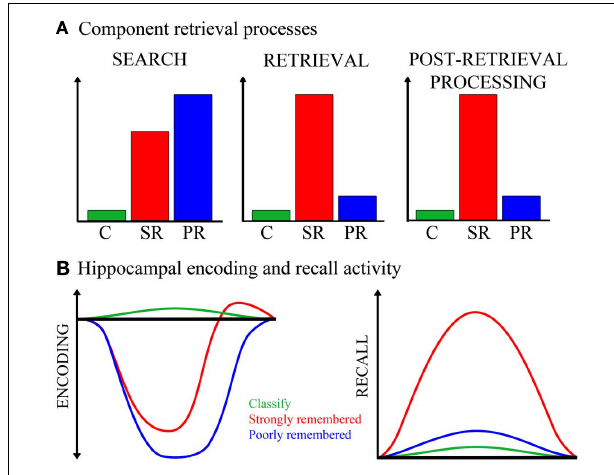
FIGURE 5 | Cognitive and neural processing models. (A) The hypothetical cognitive processes involved in an elaborative associative retrieval task, and the magnitude to which each task condition engages these processes, are depicted.The y -axis represents arbitrary units measuring degree of engagement. From this model, the following cognitive processes are expected to result from task condition contrasts: If engaged more for strongly remembered than classify, the process(es) might be search, retrieval, or post-retrieval processing; if engaged more for poorly remembered than classify and for poorly than strongly remembered, the process might be search. C, classify; SR, strongly remembered; PR, poorly remembered. (B) Hippocampal activity for each task condition is illustrated, under alternative models for encoding- and recall-mediated responses. Both strongly and poorly remembered trials are hypothesized to reduce encoding-related activity (left). Strongly remembered trials are expected to increase recall-related activity (right).The x -axes and y -axes are in arbitrary units of time and neural activity,